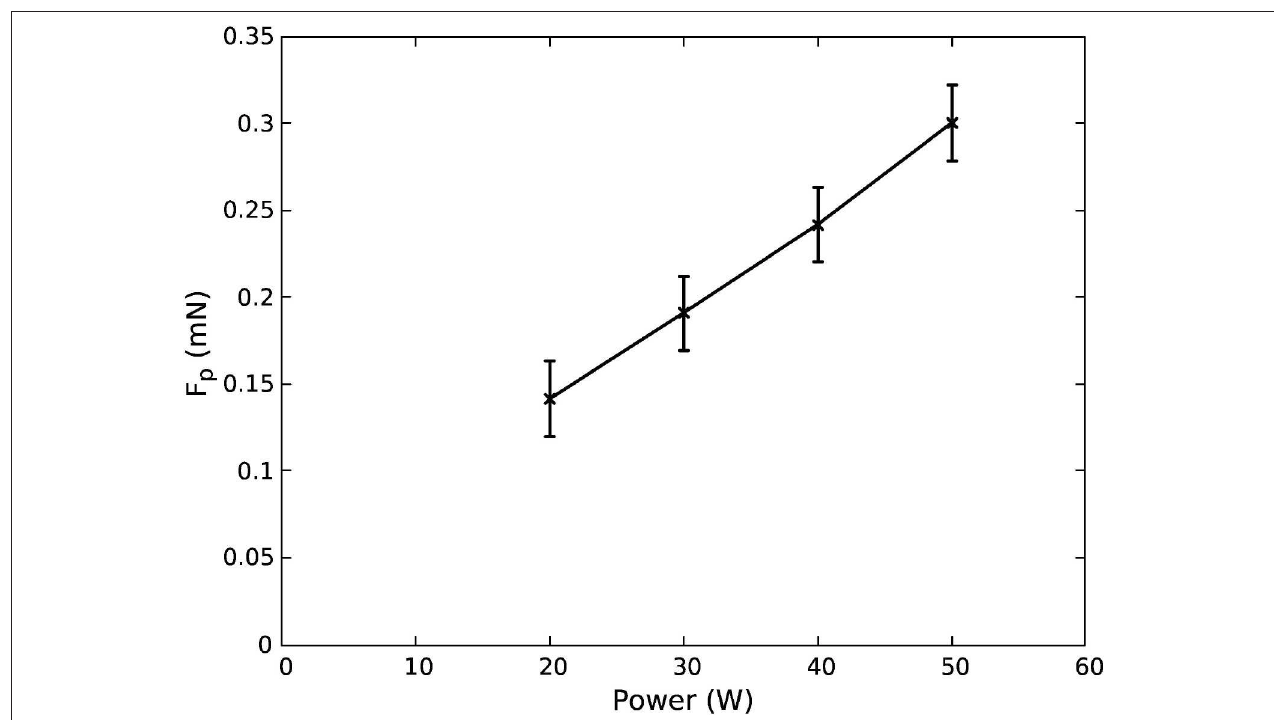
FIGURE 9 | Plasma thrust F p vs. absorbed RF power for fixed 100 SCCM argon flow (solid line, crosses). The reported thrust in this plot does not include the cold gas F cg component which is ∼ 0.8 mN, as seen in Figure 7